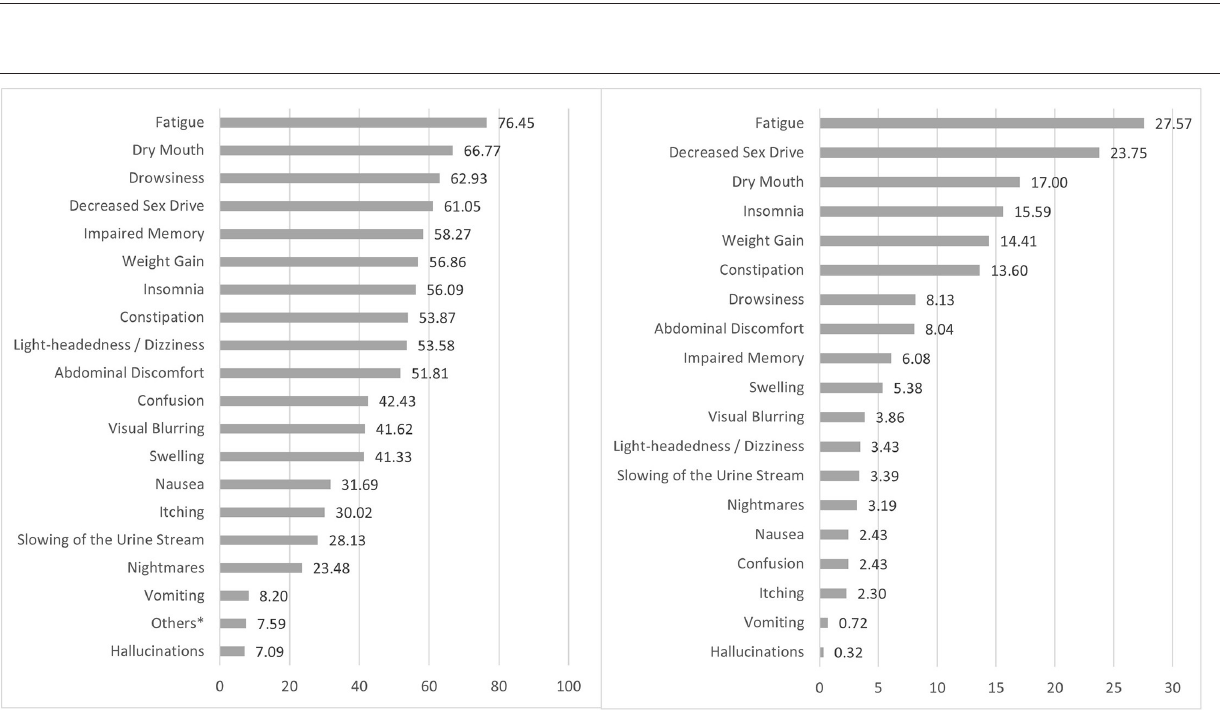
FIGURE 2 | Most frequently reported adverse effects (left) and adverse effects reported as severe (right). * Other adverse effects reported in the open-ended question at the end of the standardized checklist included stomach burn (12.75%), night sweating and hot flashes (10.78%), pain (5.88%), mood swing (4.90%), and lack of appetite